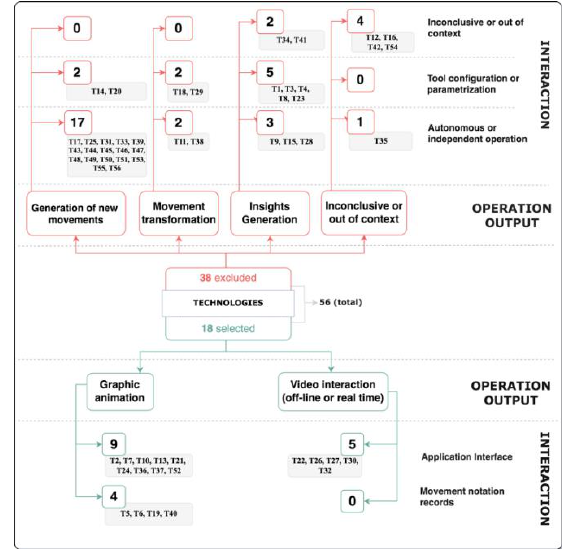
Figure 5. Research methodology used in systematic mapping. Source: The